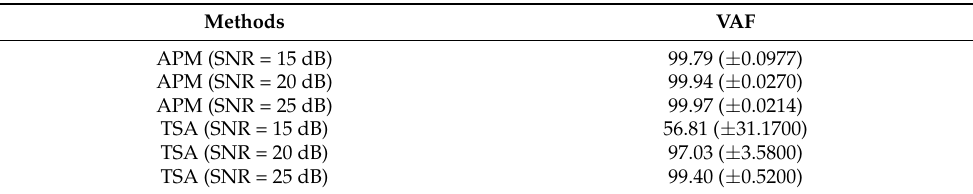
Figure 3. Histogram of VAF values of APM and TSA under different SNRs. Table 2. Estimated Results of VAF under Different SNRs.